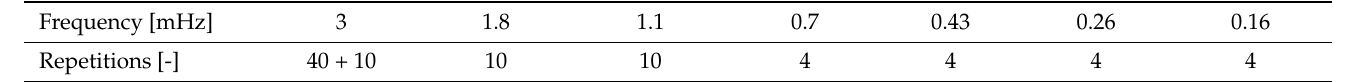
Table 1. Signal configuration per test cycle to acquire the significant